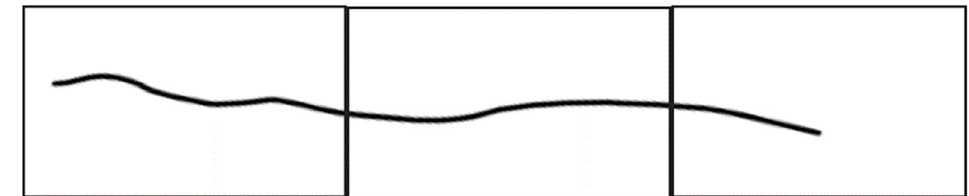
Figure 8. Bounding box detection of a crack.